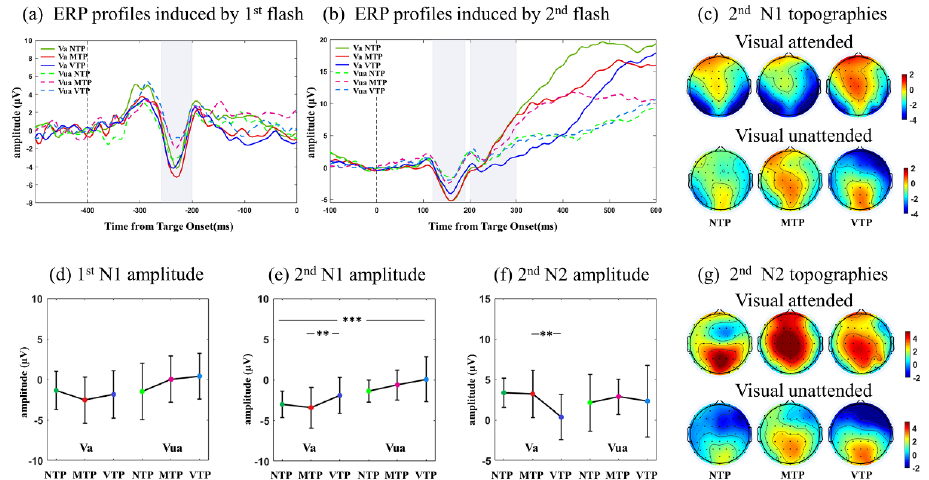
Figure 3. ( a ) Averaged ERPs of O1, OZ, O2 electrodes induced by the first flash. Va and Vua conditions were labeled by solid and dashed lines, respectively. Color green, red, blue represented NTP, MTP, VTP conditions, respectively. ( b ) ERPs of O1, OZ, O2 electrodes induced by the second flash. ( c ) N1 amplitude topographies induced by the second flash, the NTP, MTP, VTP conditions were placed in left, middle, right rows, respectively; the Va and Vua conditions were placed at upper and lower lines, respectively. ( d ) Comparisons of N1 amplitude induced by the first and ( e ) second flash. ( f ) Comparisons of N2 amplitude induced by the second flash. ( g ) N1 amplitude topographies induced by the second flash. Statistical significance: the asterisks at the top of each figure indicated the MA main effect; the asterisks above the Va condition (Va − NTP, Va − MTP, Va − NTP) indicated the TP simple effect under attended condition, when the MA-PT interactive effect existed. Statistical significance: ** 0.001 < p <0.01; *** p < 0.001.